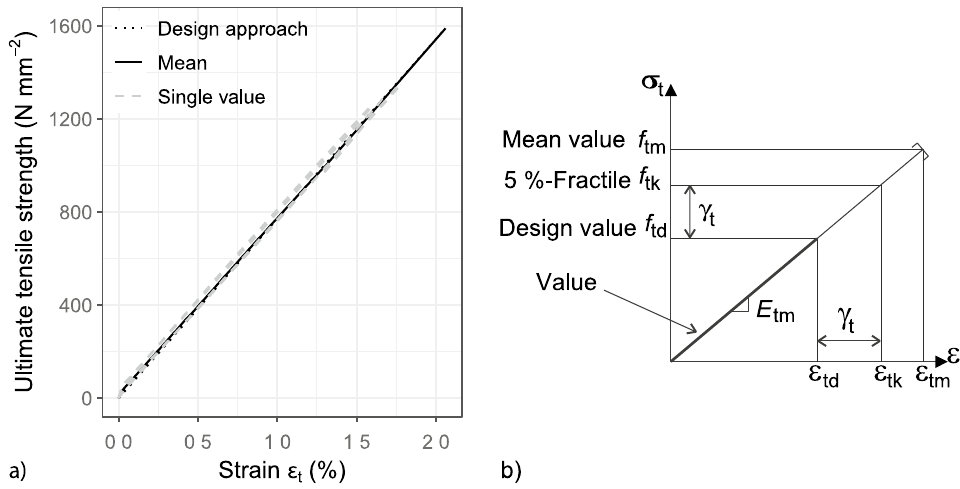
Figure 3. Stress–strain diagrams 15 ( a ) AR-Glass reinforcement. ( b ) Design of textile-reinforced